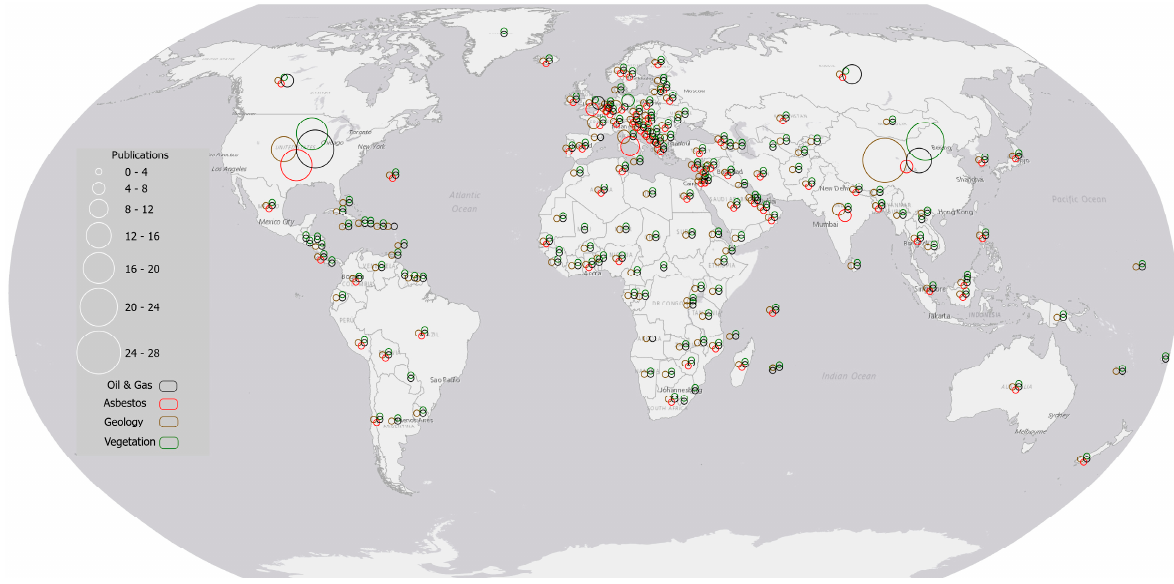
Figure 6. Summary of publications by country on oil and gas (black), asbestos (red), geology (brown), and vegetations (green).